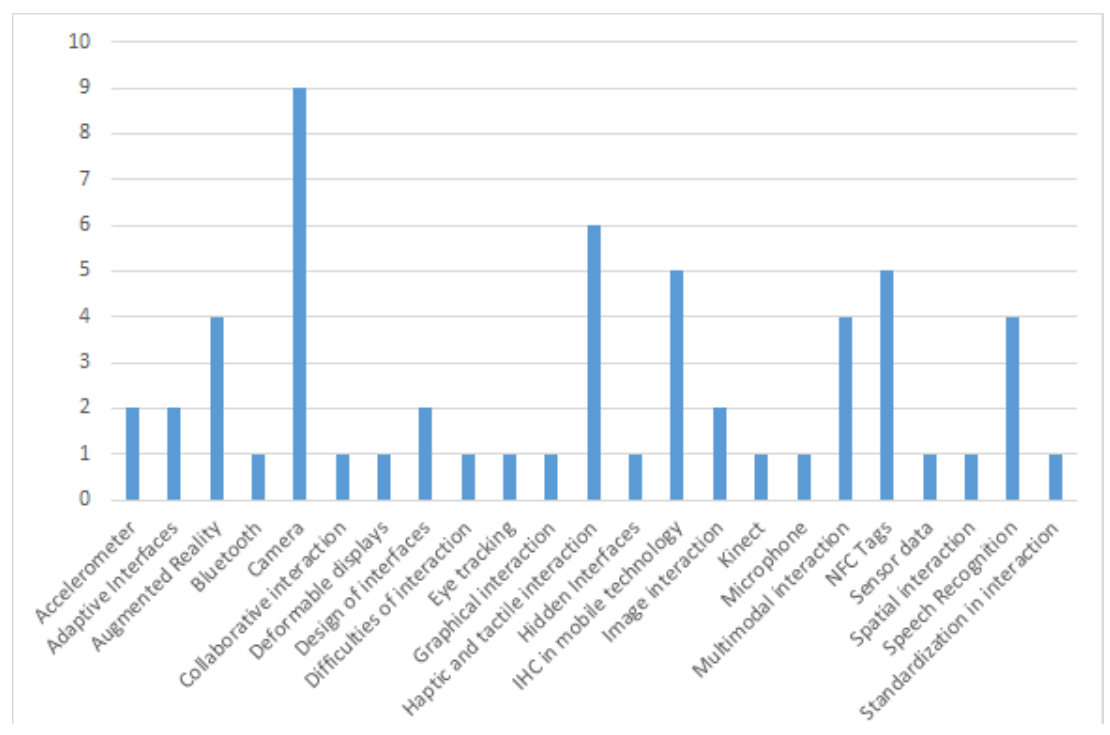
Fig. 4. Publications focused on interaction categorized by topic.